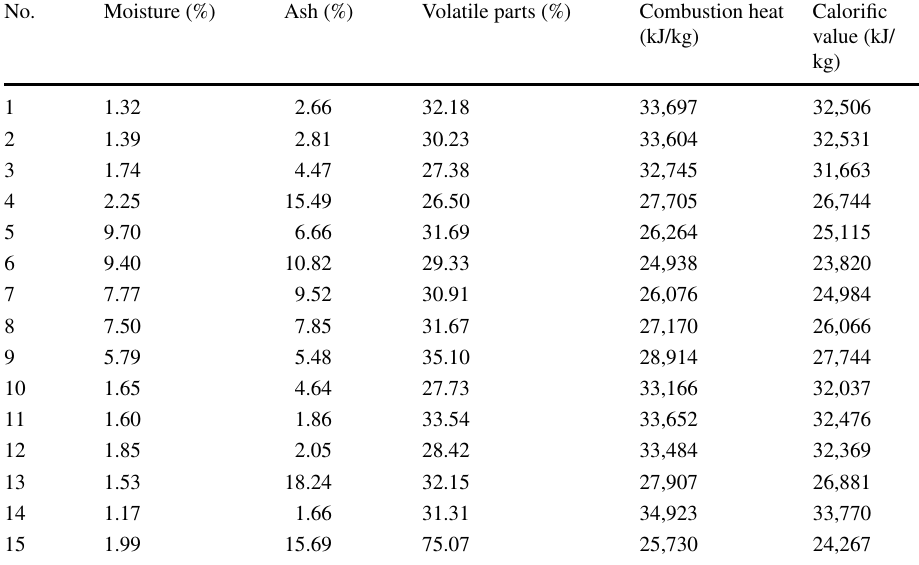
Table 1 Physical parameters